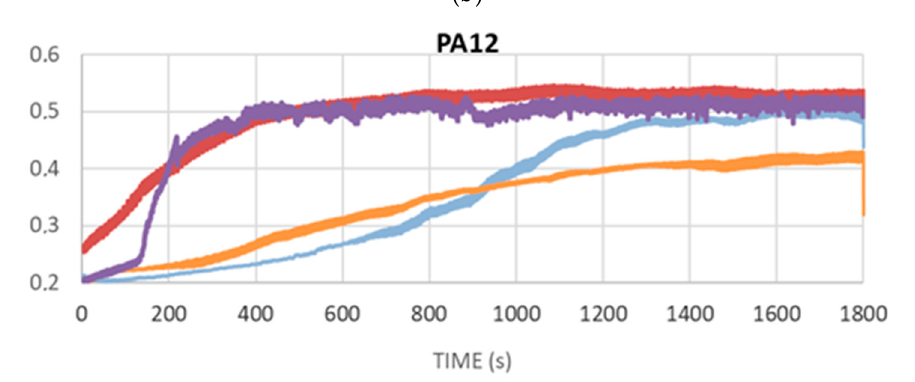
Table 2. Summary of wear test results for hybrid composites.